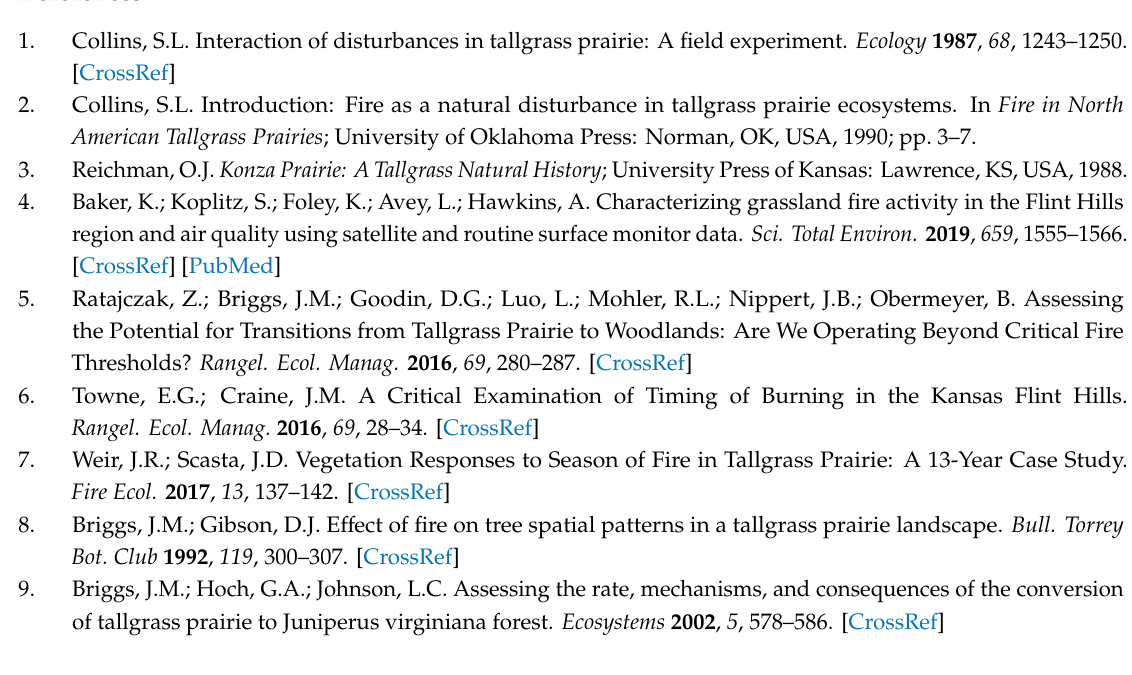
Table S1: Continuous CO, CO 2 , and MCE from 15 March 2017 burns; Table S2: Continuous CO, CO 2 , and MCE from 16 March 2017 burns; Table S3: Continuous CO, CO 2 , and MCE from 17 March 2017 burns; Table S4: Continuous CO, CO 2 , and MCE from 20 March 2017 burns; Table S5: Raw VOC canister data; Table S6: Regression statistics for VOCs present in 8 or 9 canister